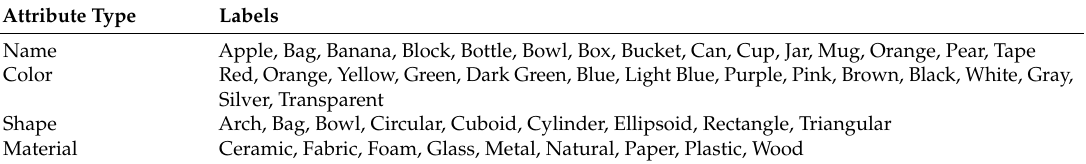
Table 3. The object attribute labels to learn.